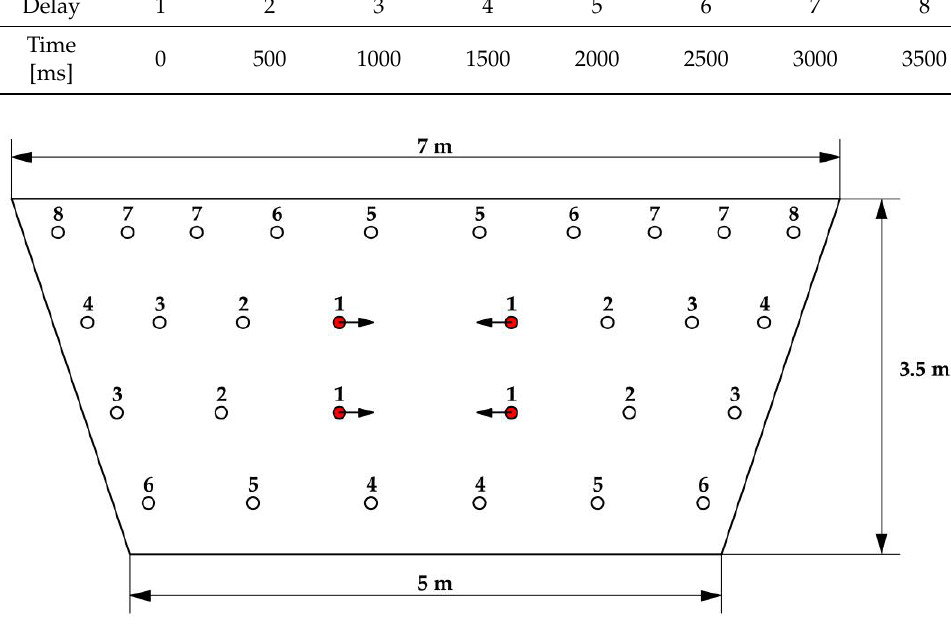
Figure 4. Drilling and blasting pattern used during multi-face blasting.